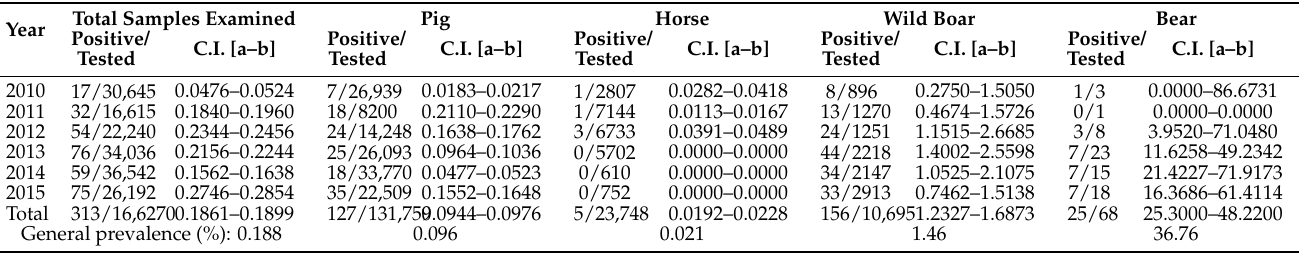
Table 1. The annual and general prevalence of Trichinella infection in animals from North-Eastern